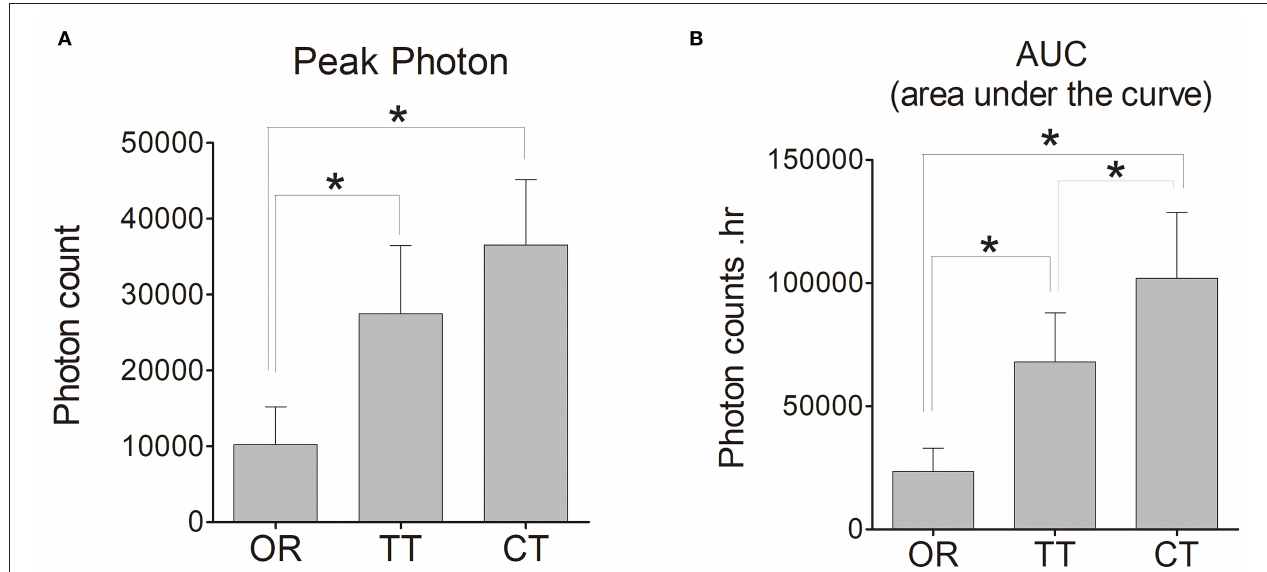
FIGURE 4 | Peak photon count and the area under the curve (AUC) of D-luciferin in the left inner ear of each group of mice. (A) Peak photon; (B) AUC. The bar graph shows the average value of mice in each group, and the error bars indicate the standard deviation. * P <